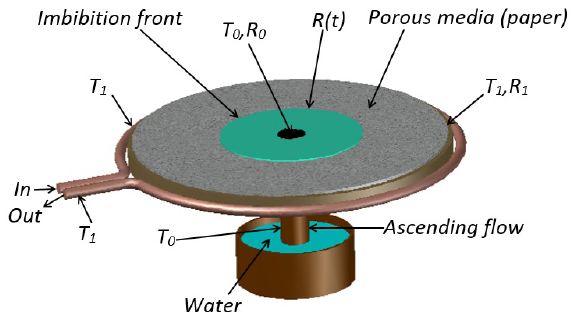
Figure 1. Schematic of the imbibition process in a thin paper on a circular copper plate. The paper sample has an inner radius R 0 and an outer radius R 1 and a thickness e . Temperatures at r = R 0 and r = R 1 are T 0 and T 1 , respectively. The green sector indicates the imbibed region, and the circular profile r = R ( t ) indicates the instantaneous position of the imbibition